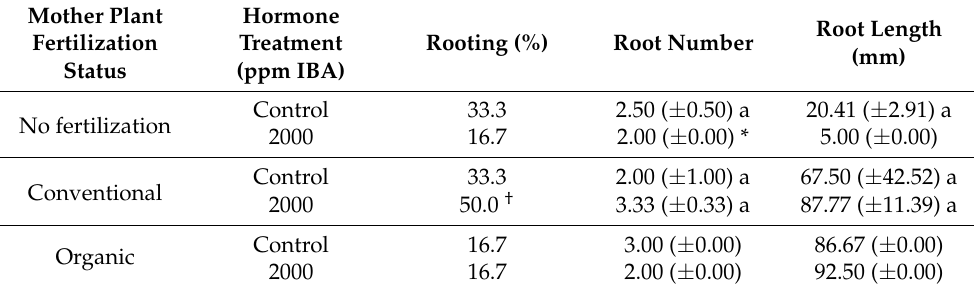
cutting managed to root, the standard error of the means for root number and length is 0.0 because they stem from a single value, as such those means are not included in the post-hoc test. Table 6. Rooting attributes of the Greek native Rosa canina genotype GR-1-BBGK-19,674 of summer 2020 trials expressed as rooting percentage (%) and mean values ( ± SEM, p < 0.05) of root number and average root length (mm) of rooted cuttings for each fertilization status and hormone treatment (ppm IBA) of mother plants. All cuttings were soft-wood, leafy sections of first growth year. The substrate type used was 3:1 perlite/peat ( v/v ) under mist conditions. Values within each column that do not share the same letter are significantly different (Tukey HSD, p < 0.05). Original data